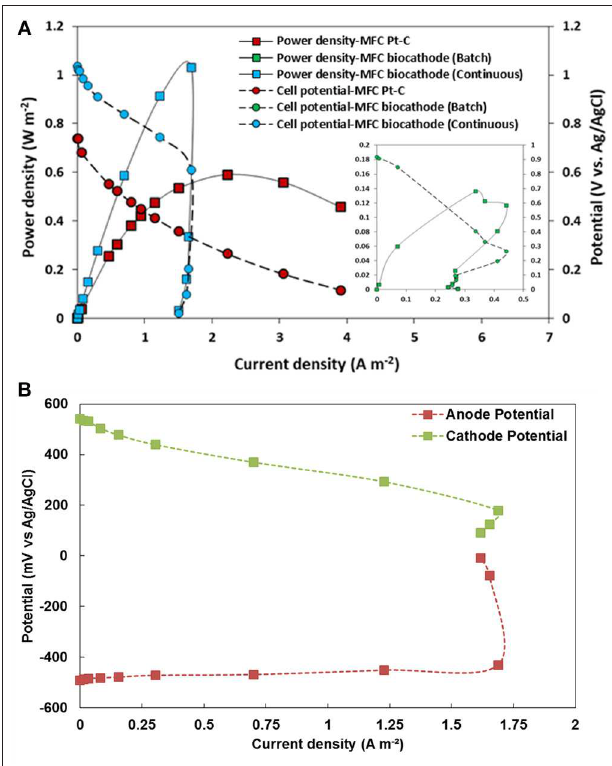
FIGURE 8 | (A) Polarization curve and power density of MFC equipped with different cathodes and operated in batch or continuous mode; (B) Anode and cathode potentials during the polarization of the MFC equipped with IOB biocathode and operated in continuous mode.